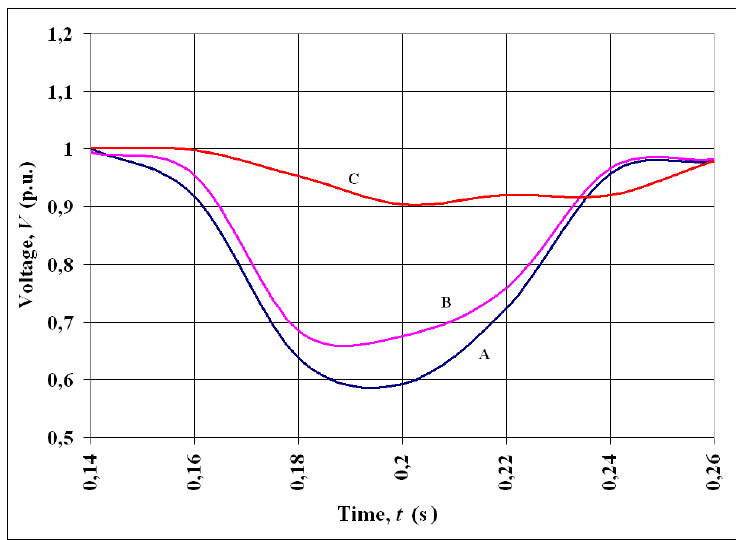
Figure 6. Two-phase voltage dip, RMS voltages